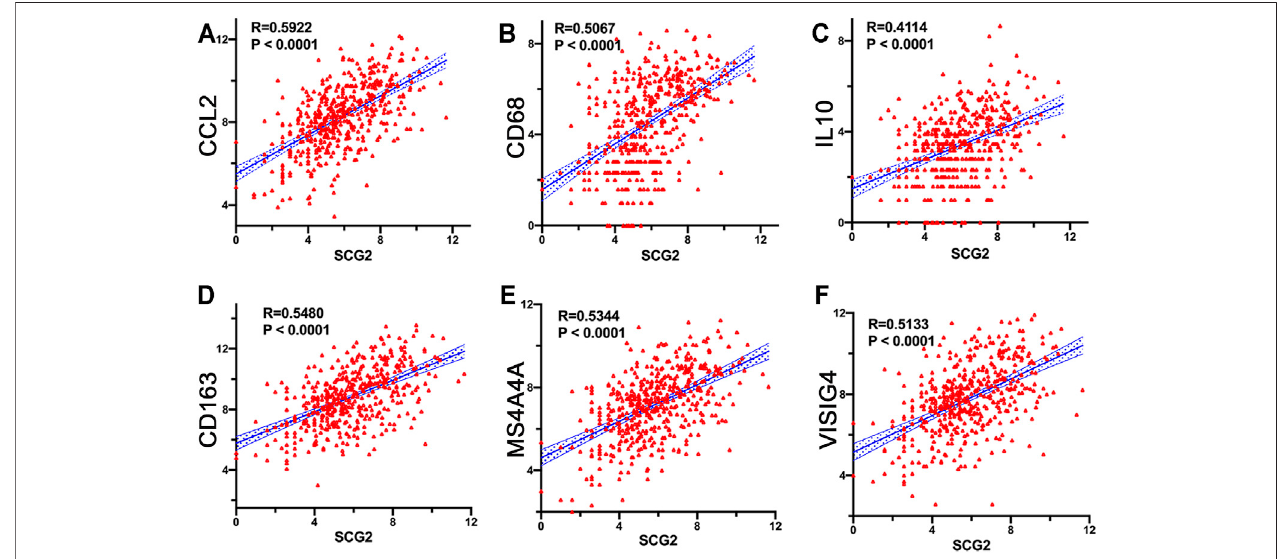
FIGURE6| Correlation ofSCG2expressionwithmacrophagepolarization. (A – C) CorrelationanalysisbetweenSCG2expressionandTAMmarkersgenes(CCL2, CD68, IL10). (D – F) Correlation analysis between SCG2 expression and M2 Macrophage markers genes (CD163, MS4A4A, VSIG4). Examined by Spearman ’ s correlation